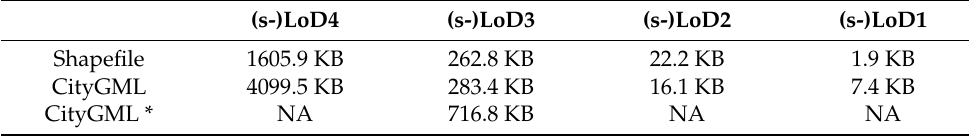
Table 13. File size of the shapefile and CityGML model of house in each